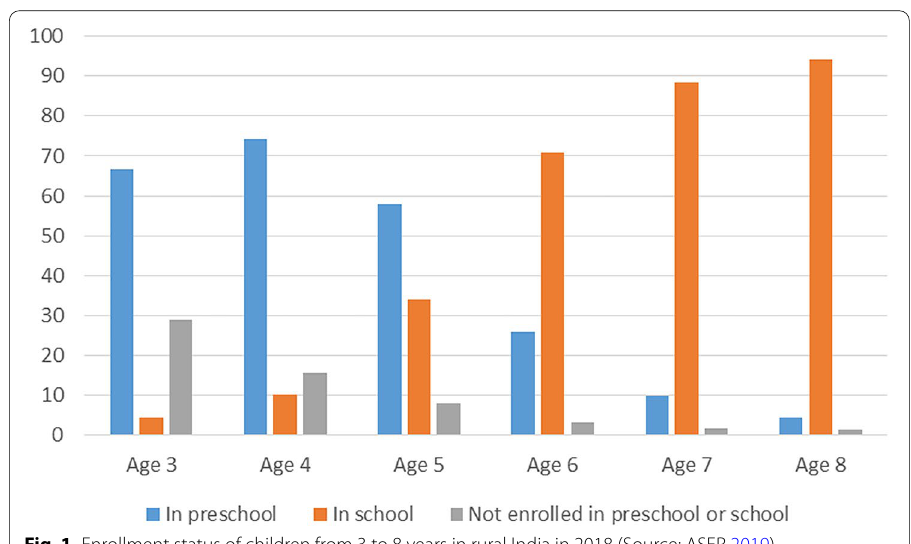
Fig. 1 Enrollment status of children from 3 to 8 years in rural India in 2018 (Source: ASER